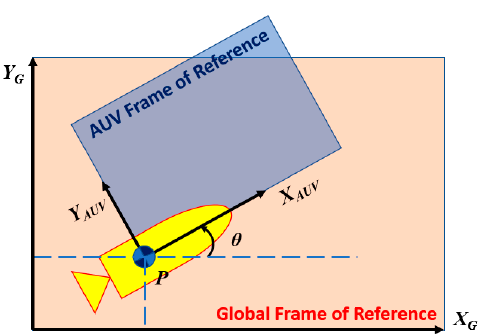
Figure 3. Autonomous underwater vehicle in the global reference frame and the local reference frame.